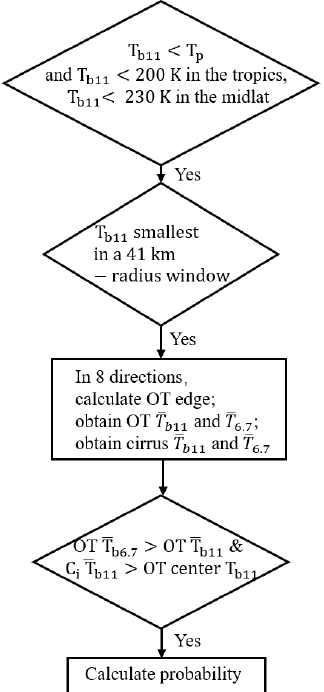
Figure 3. Flowchart for the application of IR algorithm to MODIS data. The T b represents the mean of brightness